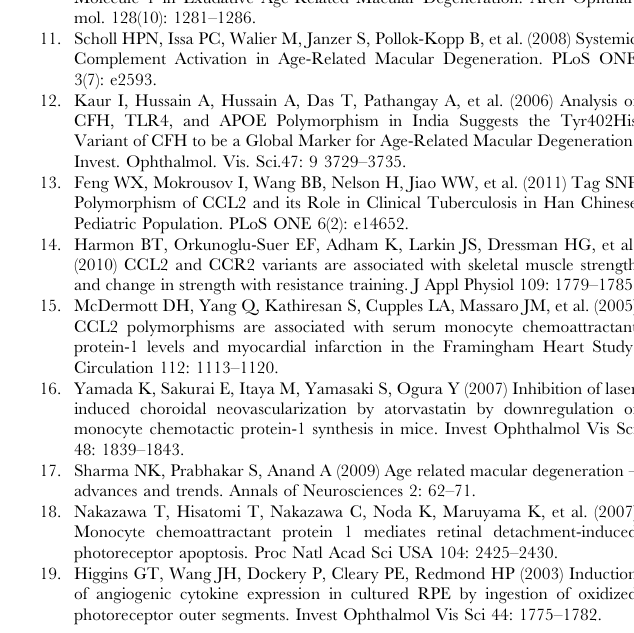
Table S1 Logistic regression of the association CCL2, CCR2 and progression of AMD stratified by food habits. Table S2 Logistic regression of the association CCL2, CCR2 and progression of AMD stratified by smoking. Table S3 Logistic regression of the association CCL2, CCR2 and progression of AMD stratified by comorbid-